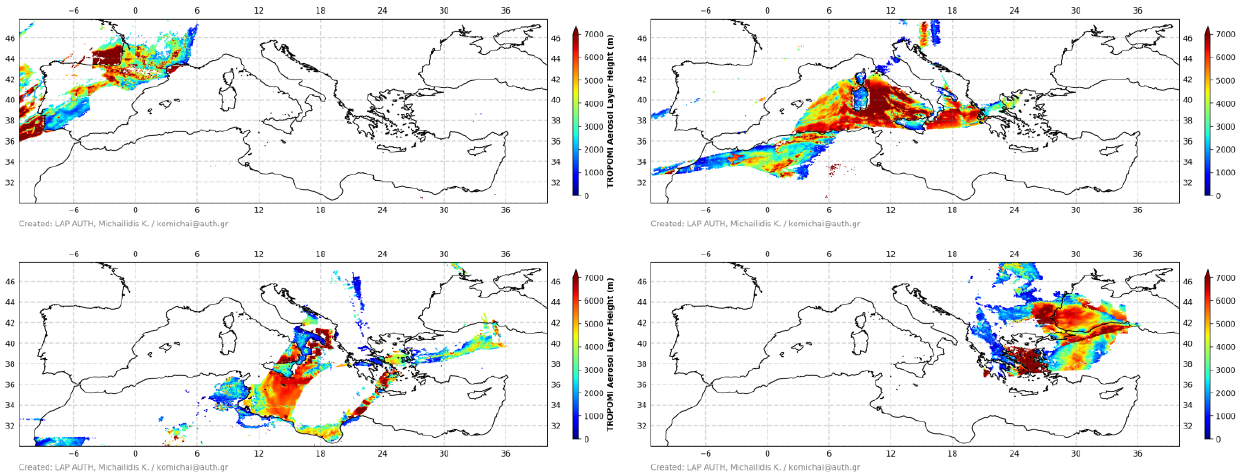
Figure 8. TROPOMI aerosol layer height (ALH) retrievals during the smoke plume transport over the Mediterranean during 24–27 Octo- ber 2020.